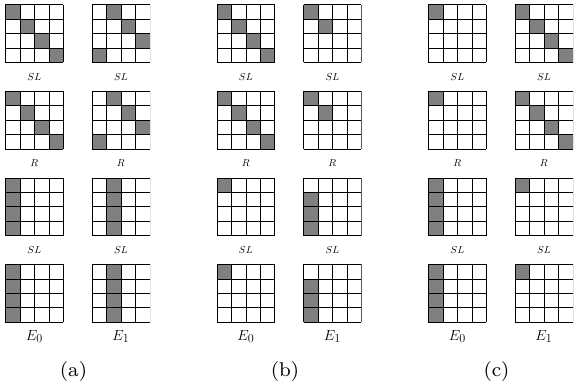
Analysis of The Three